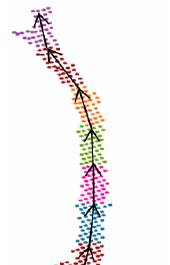
Figure 4. Stem segments and their principal